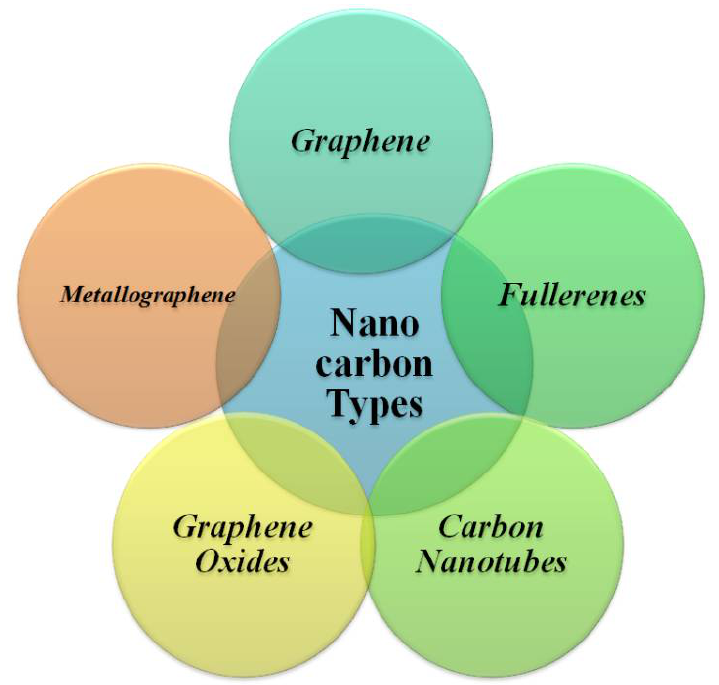
Figure 6. Different types of nanocarbons.